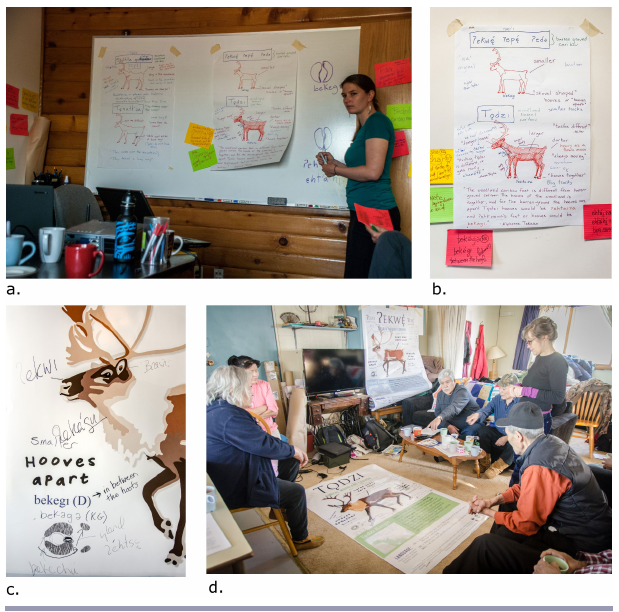
Fig. 5 . Images from the advisory group meetings depicting various visual facilitation techniques: (a) The lead author adds key ideas to the whiteboard (depictions of hoof shapes) and flip-chart illustrations of the different types of caribou during the first advisory group session in June 2014; (b) Details of the flip-chart illustration for ɂ ekwe ̨́ / ɂ ed ǝ / ɂ epe ̨́ (D/K/S) “barren- ground caribou” and to ̨ dzı “boreal caribou” including notes with Dene language in the three main dialects of the Sahtú region; (c) Details from the draft of the large poster depicting further explanations and additional information added by participants of the second advisory group meeting held in February 2015; and (d) Participants of the second advisory group meeting work together on the large to ̨ dzı